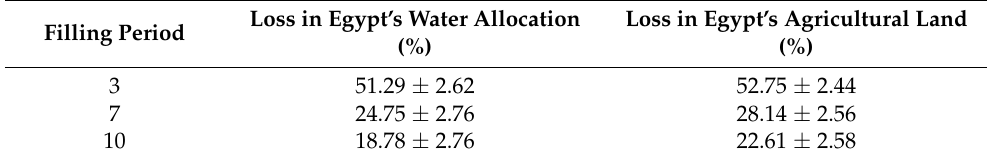
Figure 3. Average annual water loss from Egypt’s Nile water allocation (in km 3 and %) as a function of filling scenarios (in years). Table 1. Average annual losses in Egypt’s Nile water allocation and the associated losses in agricul- tural land relative to the baseline (no GERD)